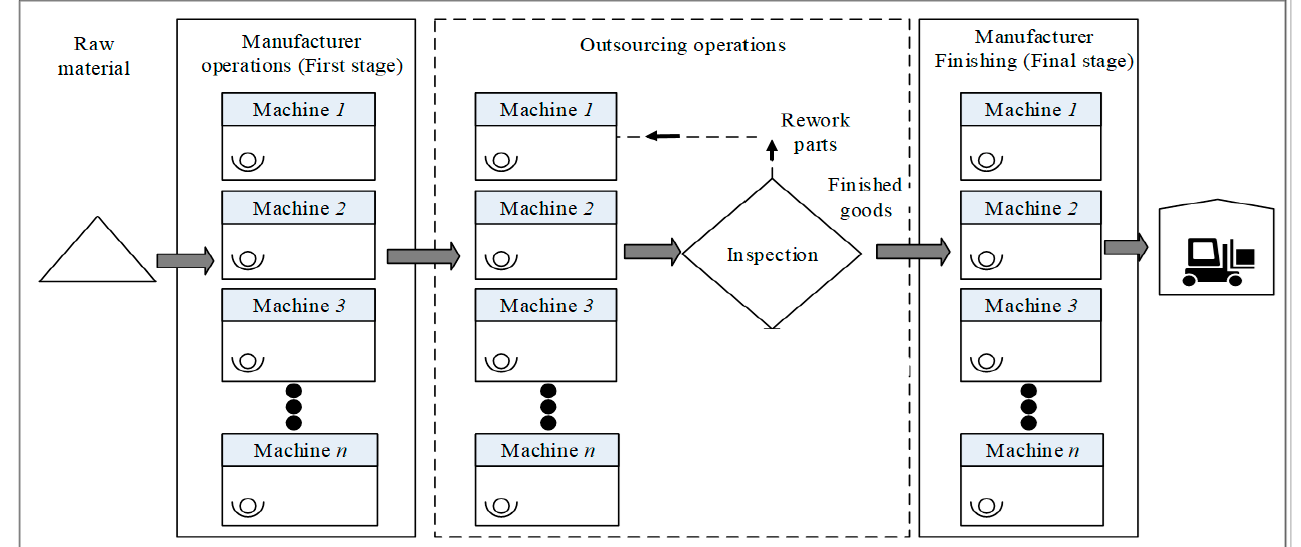
Figure 1. Production flow diagram process between manufacturer and outsourcers .